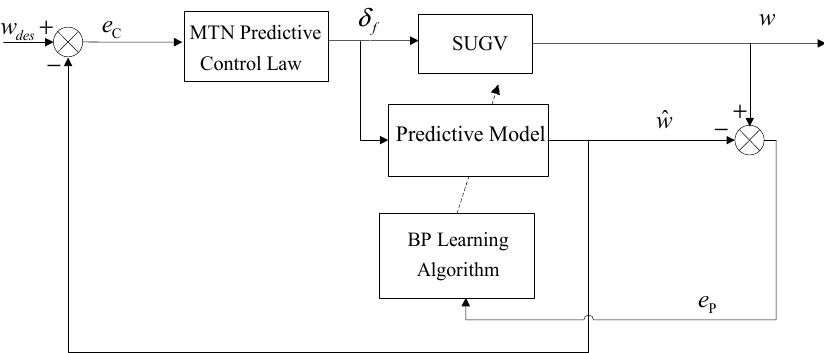
Figure 3. Block diagram of the improved MTN predictive control system. The specific steps are as shown in Algorithm 1. Algorithm 1 Scheme of MTN Predictive Control with the Differential Term